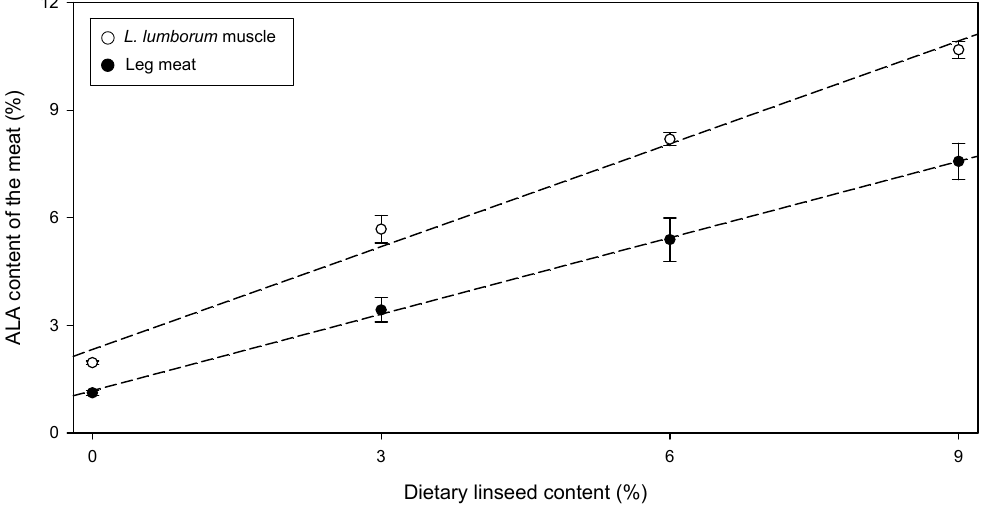
Figure 1. Relationship between dietary linseed and α -linolenic acid (ALA) content (mean ± sem) in rabbit meat ( L. lumborum muscle: y = 0.71x + 1.18, R 2 = 0.999;